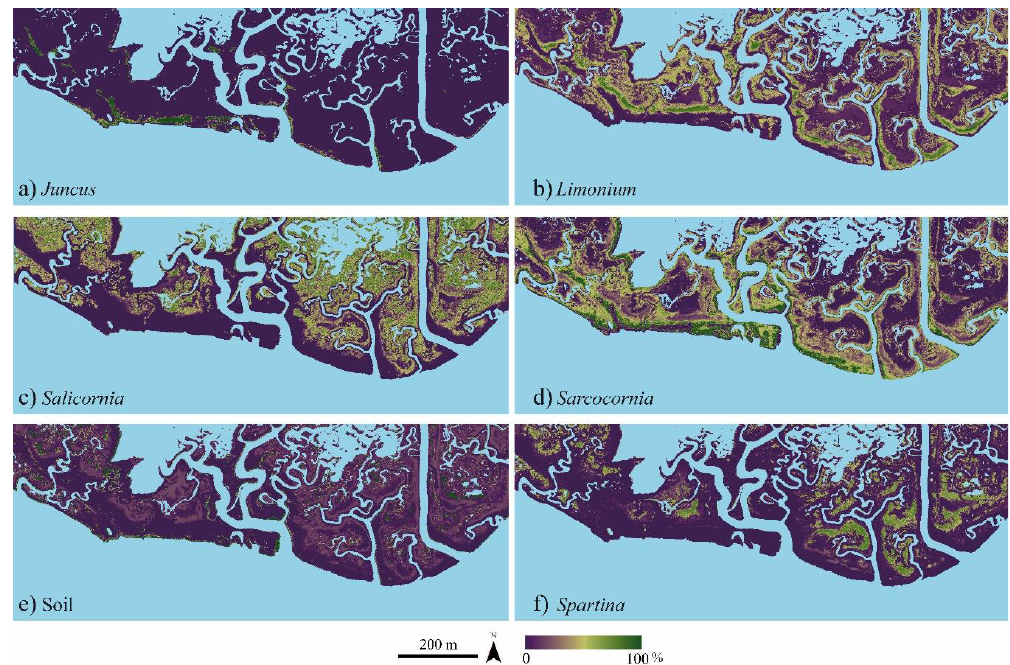
Figure 5. Maps of the individually predicted abundance of vegetation species obtained based on the RF regression. Specifically, ( a – f ) are maps of abundance of Juncus , Limonium , Salicornia , Sarcocornia , Soil and Spartina , respectively. Light blue areas represent water. Table 4. Accuracy information for RF regression. Jun = Juncus , Lim = Limonium , Sali = Salicornia , Sarc = Sarcocornia and Spar = Spartina .